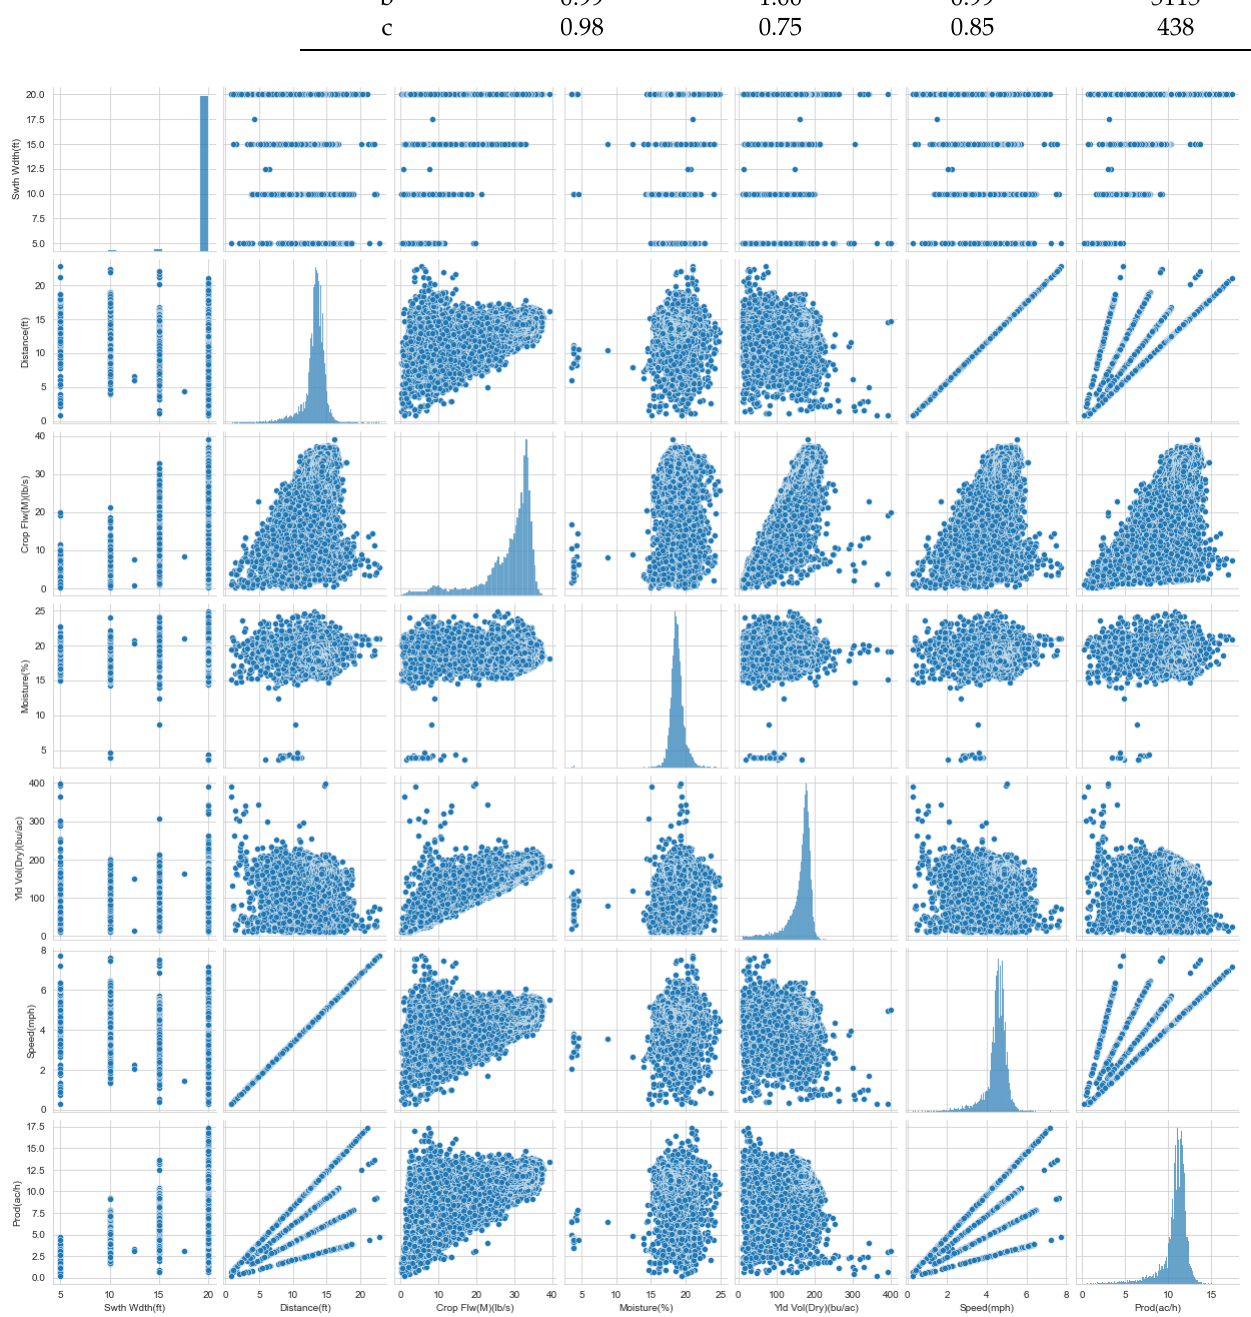
Figure 4. Pair plot with respect to all